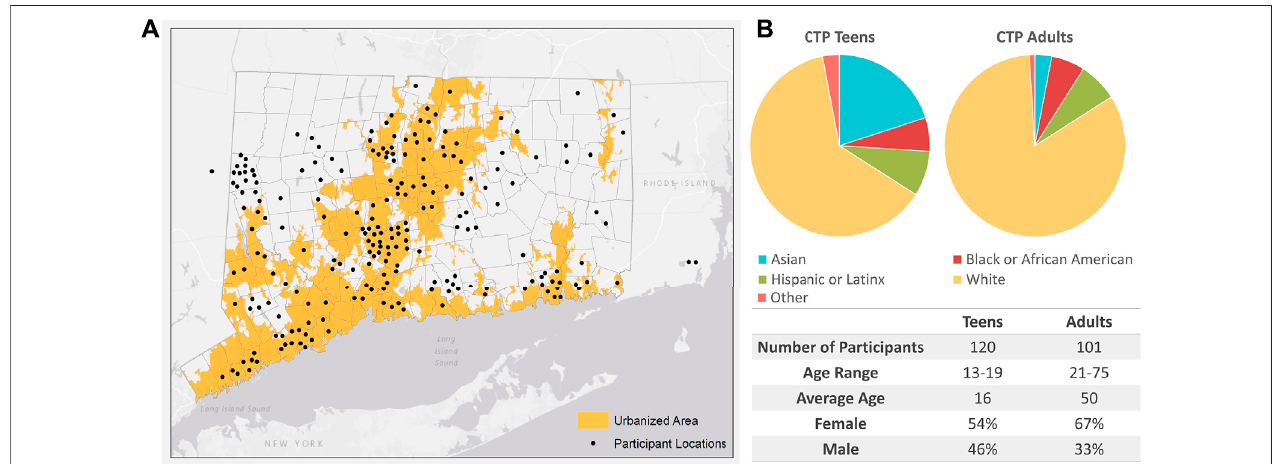
FIGURE 1 | (A) A distribution map showing the locations (black dots) of each UConn-CTP participant ’ s community, which serves as the general location of each conservation project, throughout Connecticut and nearby states. Participants ’ communities fall along an urban (yellow shading) to rural (no shading) gradient, thus providing diverse context for community conservation projects (B) Demographic data from 221 UConn-CTP teen and adult participants.